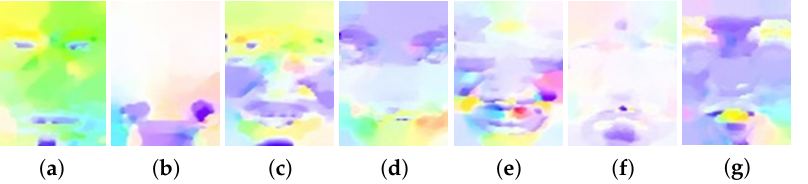
Figure 3. Examples of dense motion flow of different facial expressions. Optical flow is color-coded by its direction and intensity. ( a ) Anger, ( b ) Contempt, ( c ) Disgust, ( d ) Fear, ( e ) Happiness, ( f ) Sadness, ( g )